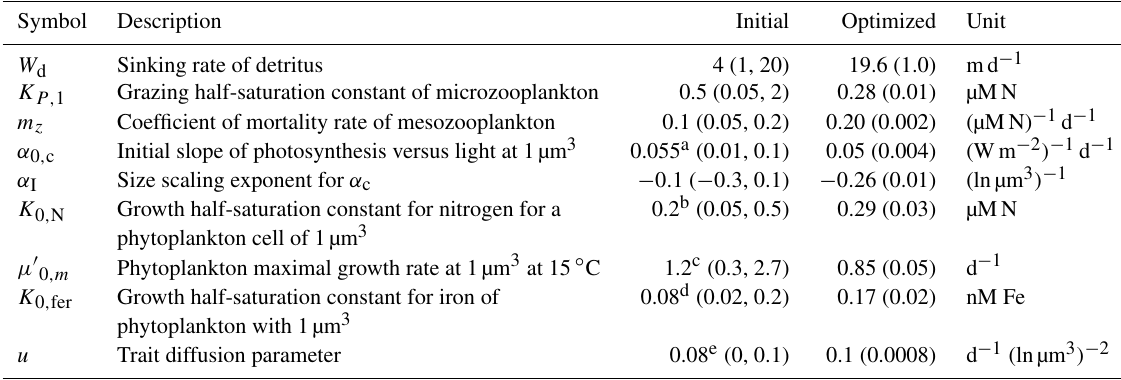
Table 2. Parameters optimized by the DRAM algorithm. The values inside the parentheses of the initial values indicate the “hard” boundaries for the parameters. The numbers inside the parentheses of the optimized values indicate the standard deviation after the first 10000 iterations have been